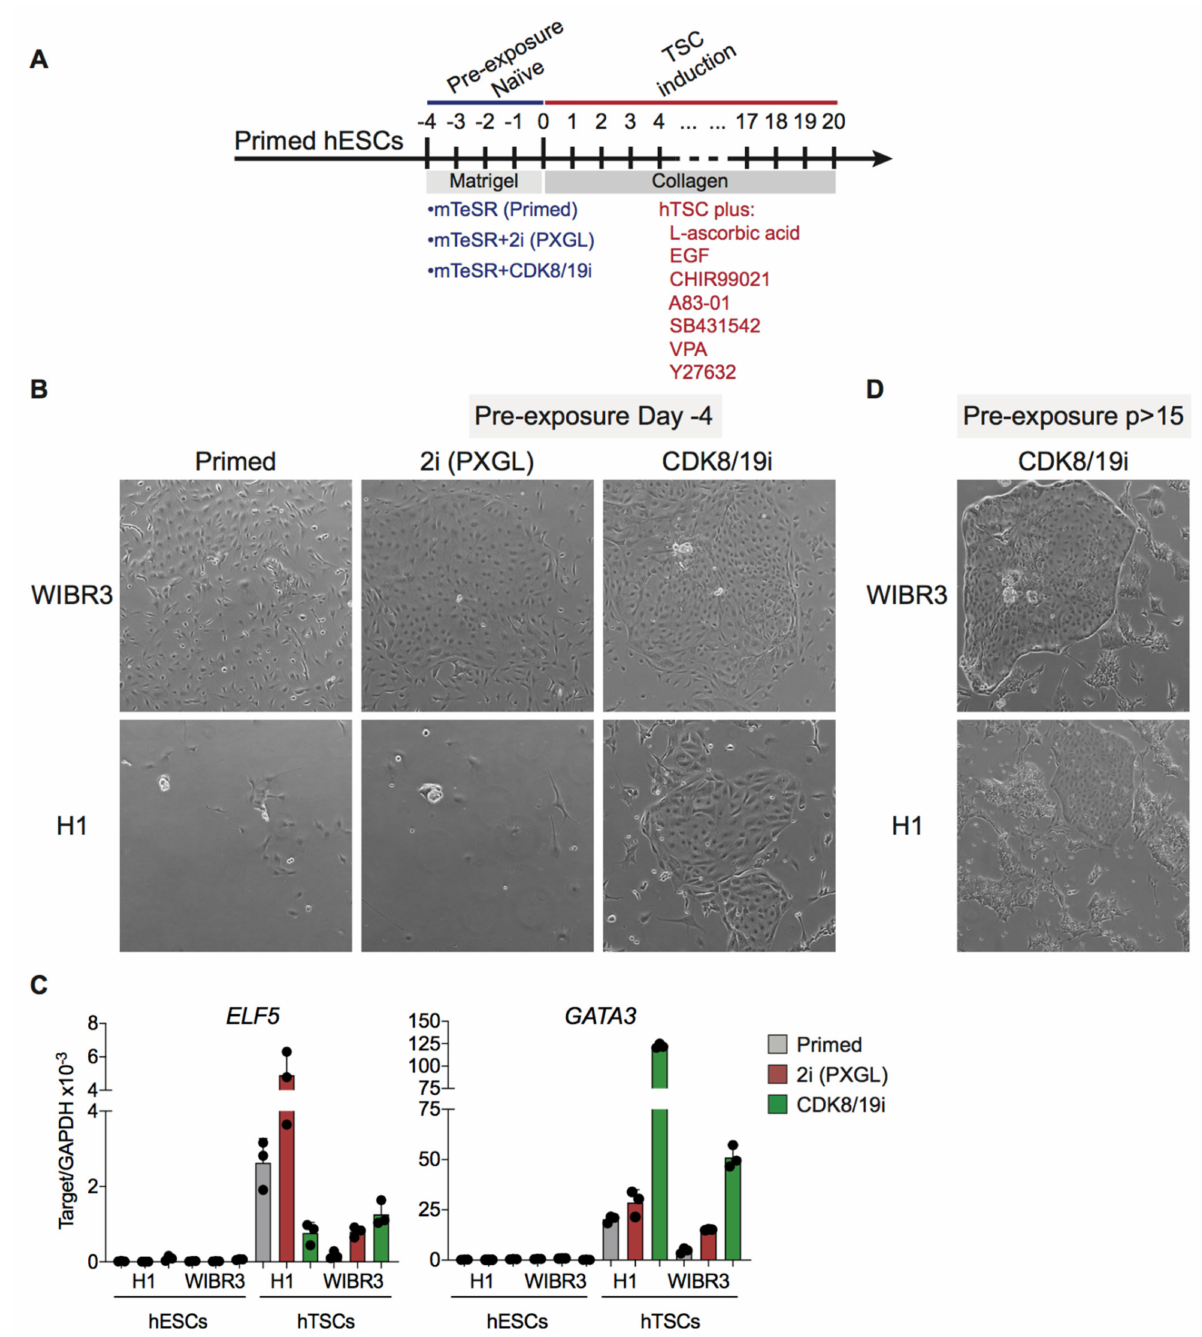
Figure 4. CDK8/19i-naïve hPSCs can differentiate into trophoblast stem cells (hTSCs). ( A ) Experimental scheme for assessing hTSCs differentiation of primed, 2i (PXGL) and CDK8/19i-naïve hESCs. ( B ) Brightfield images showing hTSC-like colonies derived from hESCs (WIBR3 and H1) after exposure to short-term naïve conditions. ( C ) mRNA expression level of selected trophoblast markers assessed by qRT-PCR. Data are mean ± Std Dev of 3 technical replicates. ( D ) Brightfield images showing hTSC-like colonies derived from hESCs (WIBR3 and H1) after more than 15 passages ( p >